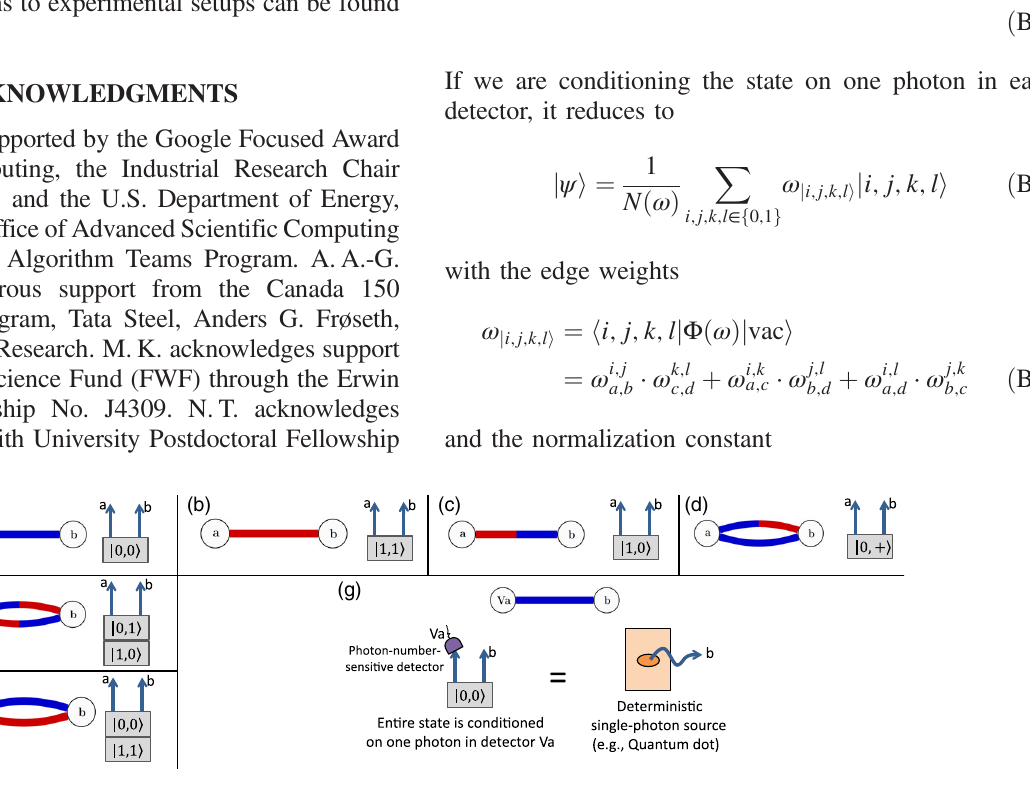
FIG. 7. Graph to experiment translation for individual edges. Designing quantum optical experiments using the abstract notation of graphs is possible because we find translations of graphs into several different experimental schemes. Edges between vertices a and b are translated to probabilistic photon sources; see (a) – (f). Edge colors correspond to mode numbers. Multiedges correspond to superposition or entanglement and can be created with standard photonic technologies, for example, cross-crystal sources [75,76]. (g) A deterministic single-photon source emitting in path b can be understood as an edge between a vertex b and a virtual vertex Va. For each term in the resulting quantum state, every virtual vertex always needs to have exactly one incoming edge. This constraint is conceptually equivalent to the situation of a probabilistic photon-pair source, where the whole state is conditioned on the detection of one photon using a photon- number-sensitive detector in path